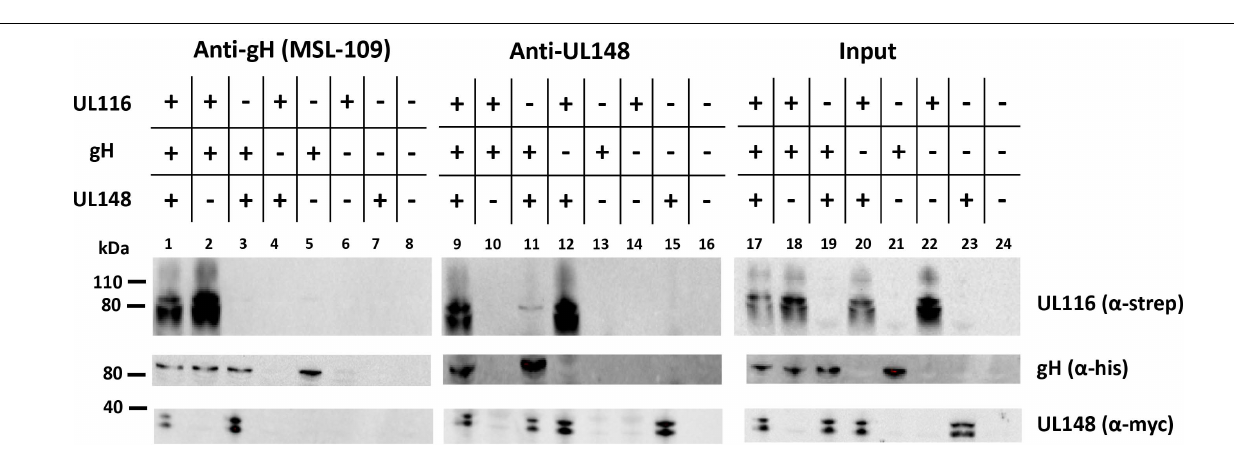
FIGURE 7 | Co-immunoprecipitaions from transfected cells. pCDNA3.1(–)-gH_myc, pCDNA3.1(–)-UL116_strep, and pCDNA3.1(–)-UL148_mycHis were used to transiently transfect HEK-293T cells, either alone or in combination to each other as specified on the top of the figure. pCDNA3.1(–) was used as control (lanes 8,